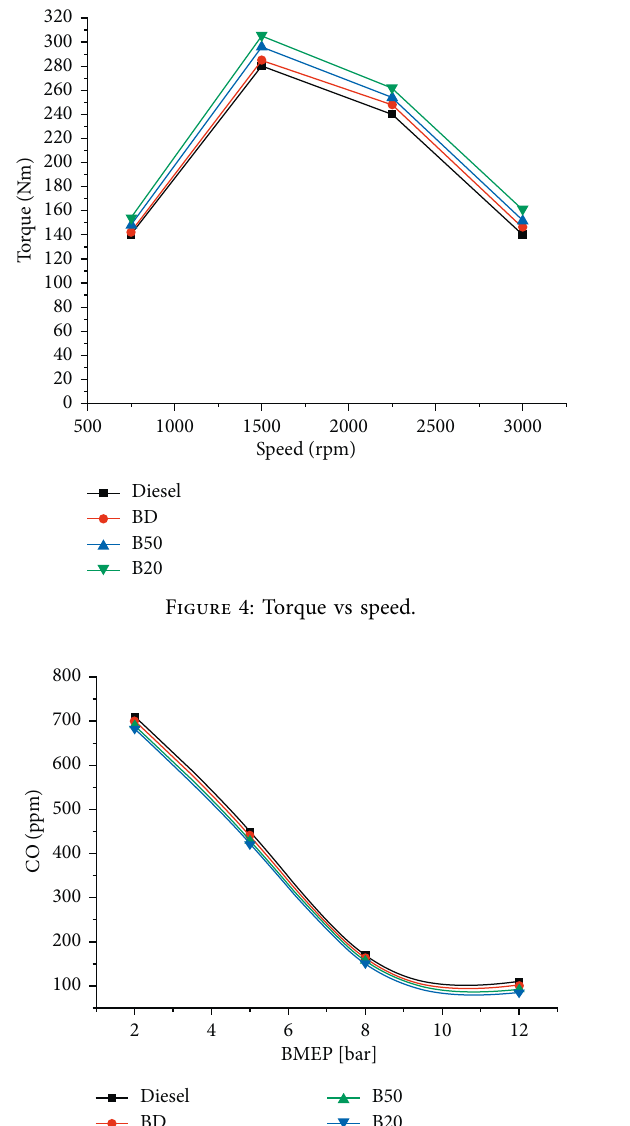
Figure 5: CO emission with bmep @ 1500rpm.